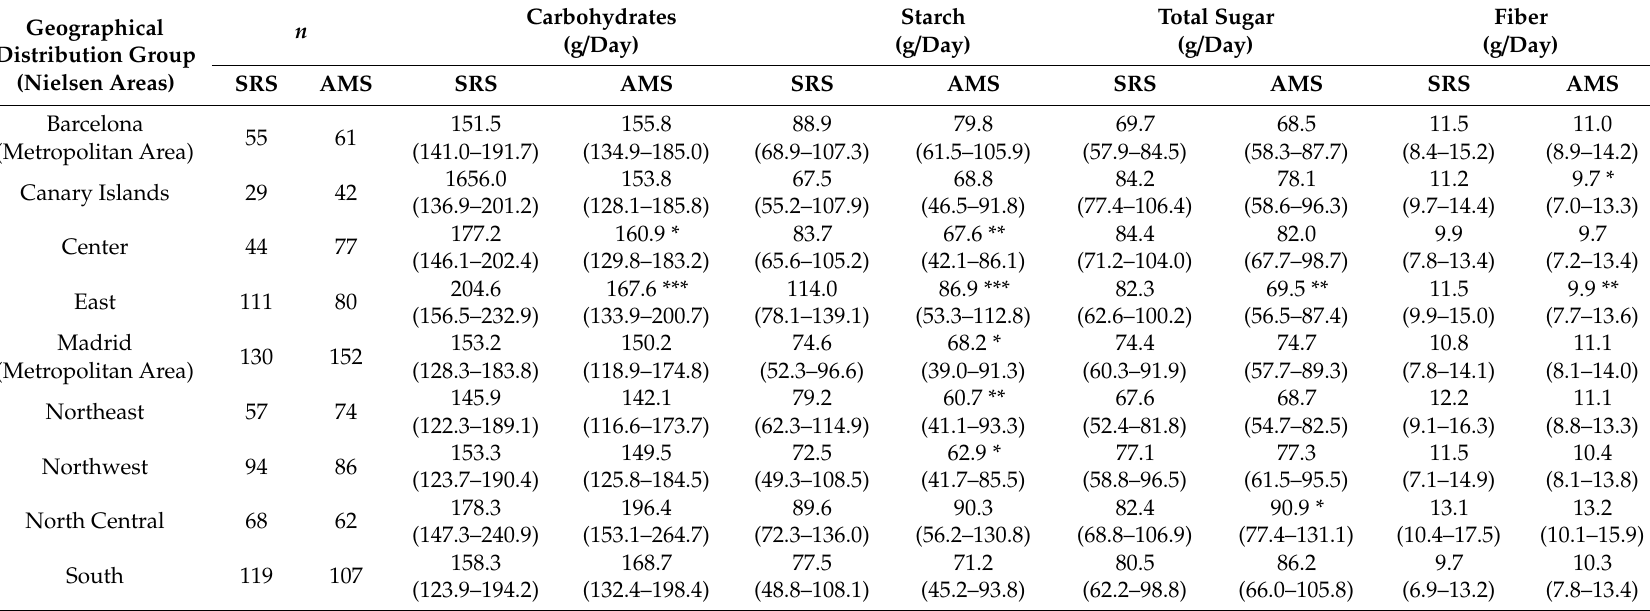
Table 5. Total carbohydrates, starch, total sugar, and fiber intakes by geographical distribution amongst the Spanish Reference Cohort (SRS) and the Adapted Milk Consumers Cohort (AMS) in the Spanish Pediatric Population (EsNuPI)